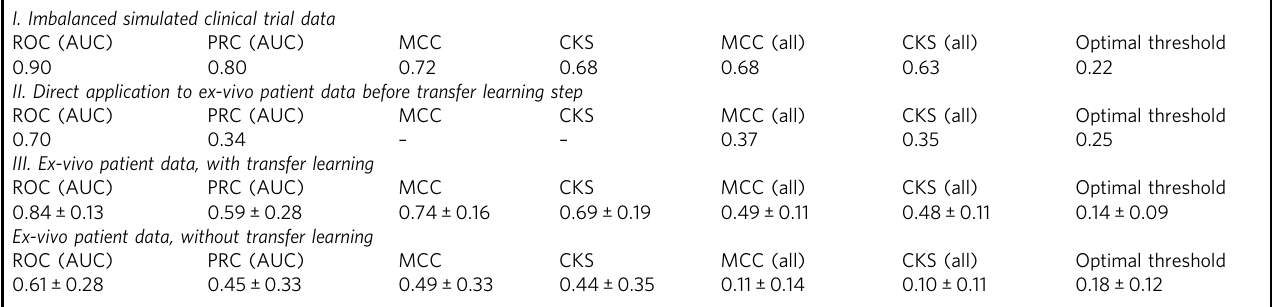
Table 3 Classi fi cation results obtained by using the tumor micro-environment features as inputs to the C-SBINN. I. Imbalanced simulated clinical trial data ROC